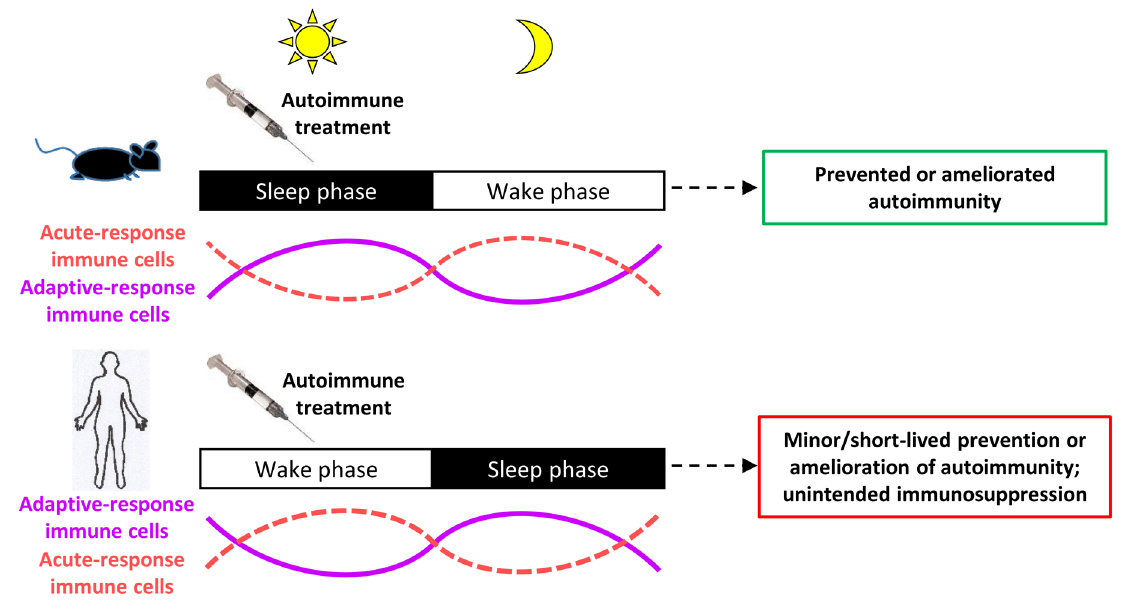
Figure 1. Autoimmunity treatments are applied at opposite immune system peaks in mice compared to humans. Humans and mice have different wake/activity and sleep/rest phases with regard to the daylight cycle. Because of this, researchers perform autoimmunity treatments at very different immune system peak times in humans compared to mice, which may account for some disappointing treatment trial outcomes in human